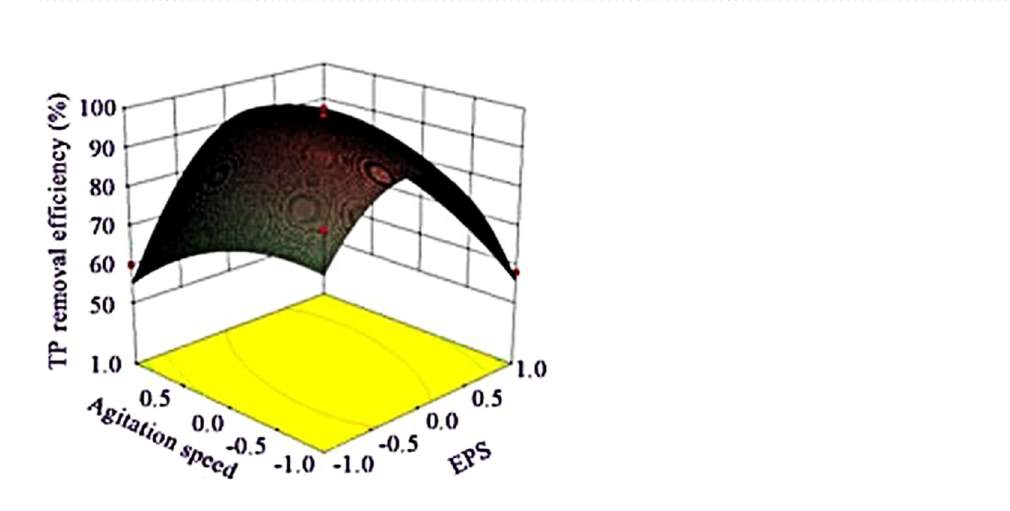
Figure 4. Surface graphs of COD removal efficiency showing the effect of variables: ( a ) PAC-EPS; ( b ) EPS-pH.